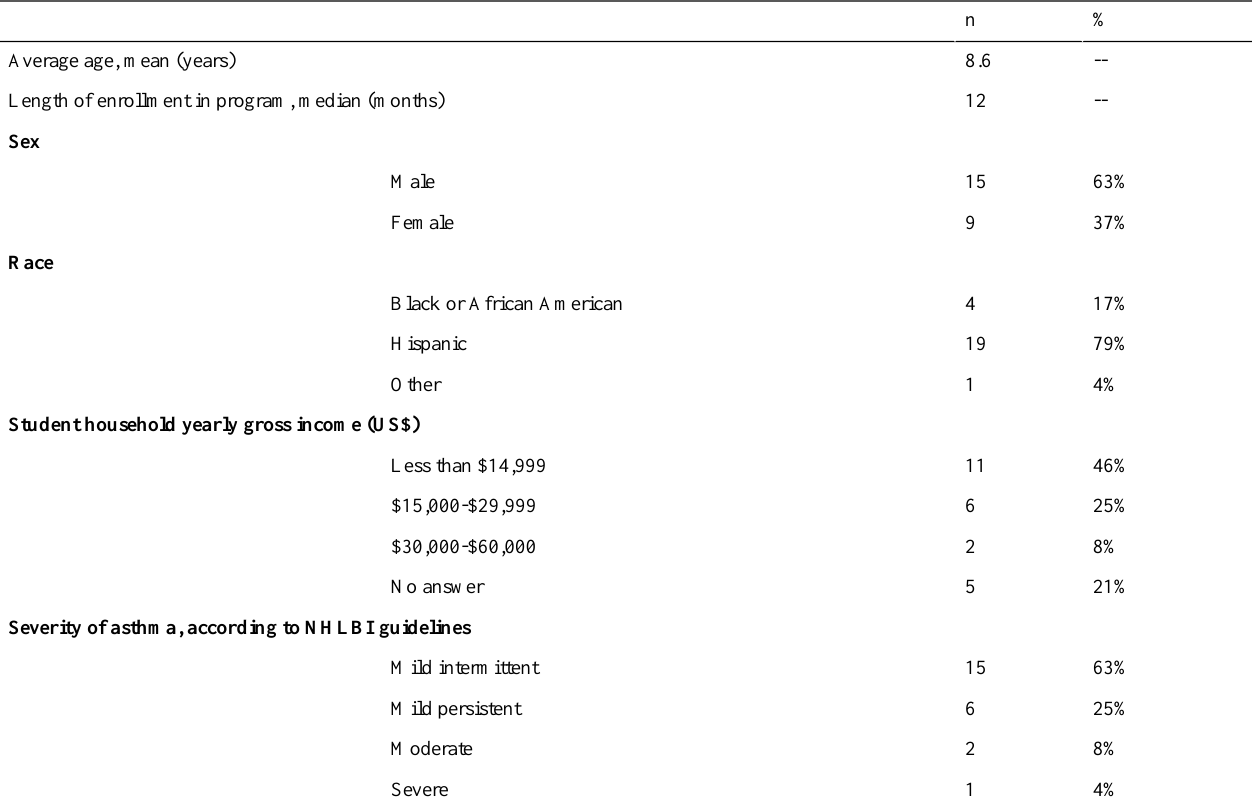
Table 2. Baseline demographic characteristics of program enrollees a (n =